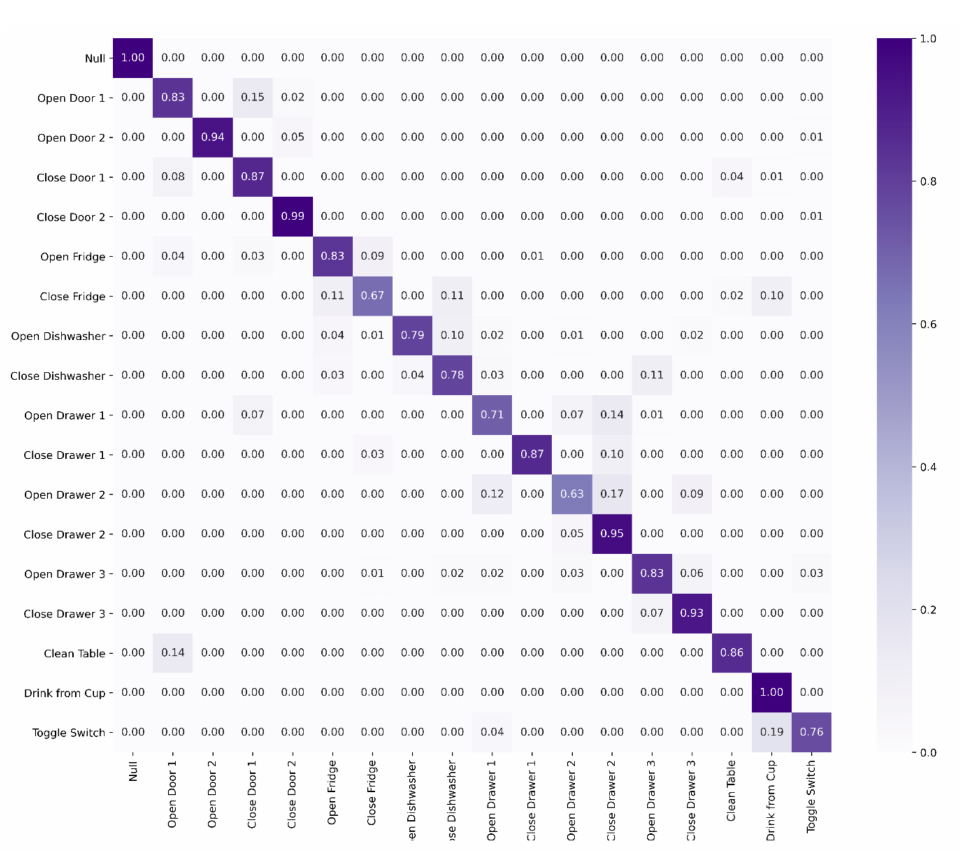
Figure 13. ( a ) Training and validation loss, ( b ) F1-score on training dataset for upper body recogni- tion model.